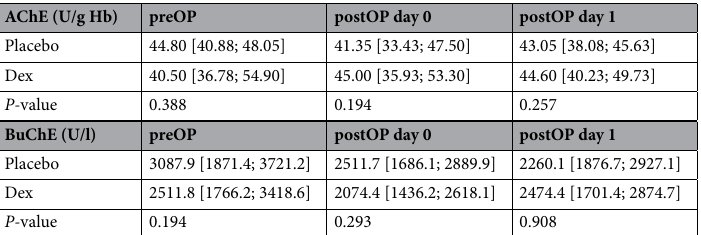
Table 3. Activities of acetylcholinesterase (AChE) and butyrylcholinesterase (BChE) before (preOP), 15 min after (postOP day 0) and one day after surgery (postOP day 1) compared between patients receiving standard general anaesthesia (Placebo, n = 30) or general anaesthesia combined with perioperative dexmedetomidine (Dex, n = 26). Tables show medians with interquartile ranges. P -values compare values at individual points in time between both groups with the Mann–Whitney U